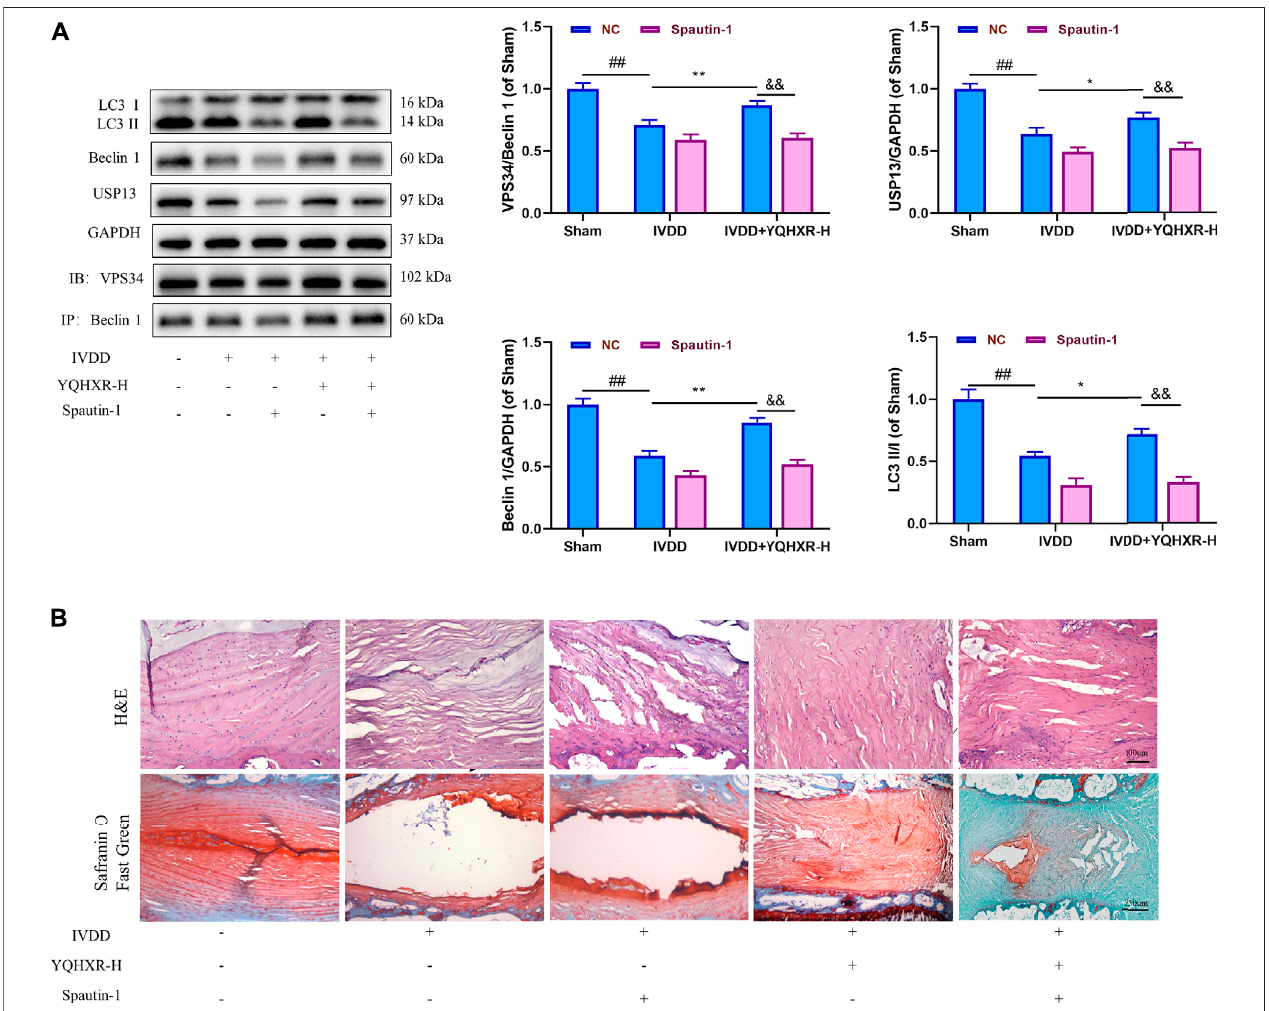
FIGURE 5 | YQHXR increased the protein level of the ubiquitinase USP13 for the inhibition of Beclin1 degradation. (A) The effect of YQHXR on stabilization of Beclin1-VPS34 complex in the absence or presence of Spautin-1 was analyzed by western blotting and immunoprecipitation analysis. (B) The effect of YQHXR on the pathologicalchangesofIVDDratsintheabsenceorpresenceofSpautin-1.Thedatarepresentthemean ± SD.Signi fi cantdifferencesamongdifferentgroupsareshown as ## p < 0.01 vs Sham + NC group; * p < 0.05, ** p < 0.01 vs IVDD + NC group; && p < 0.01 vs IVDD + YQHXR-H + NC